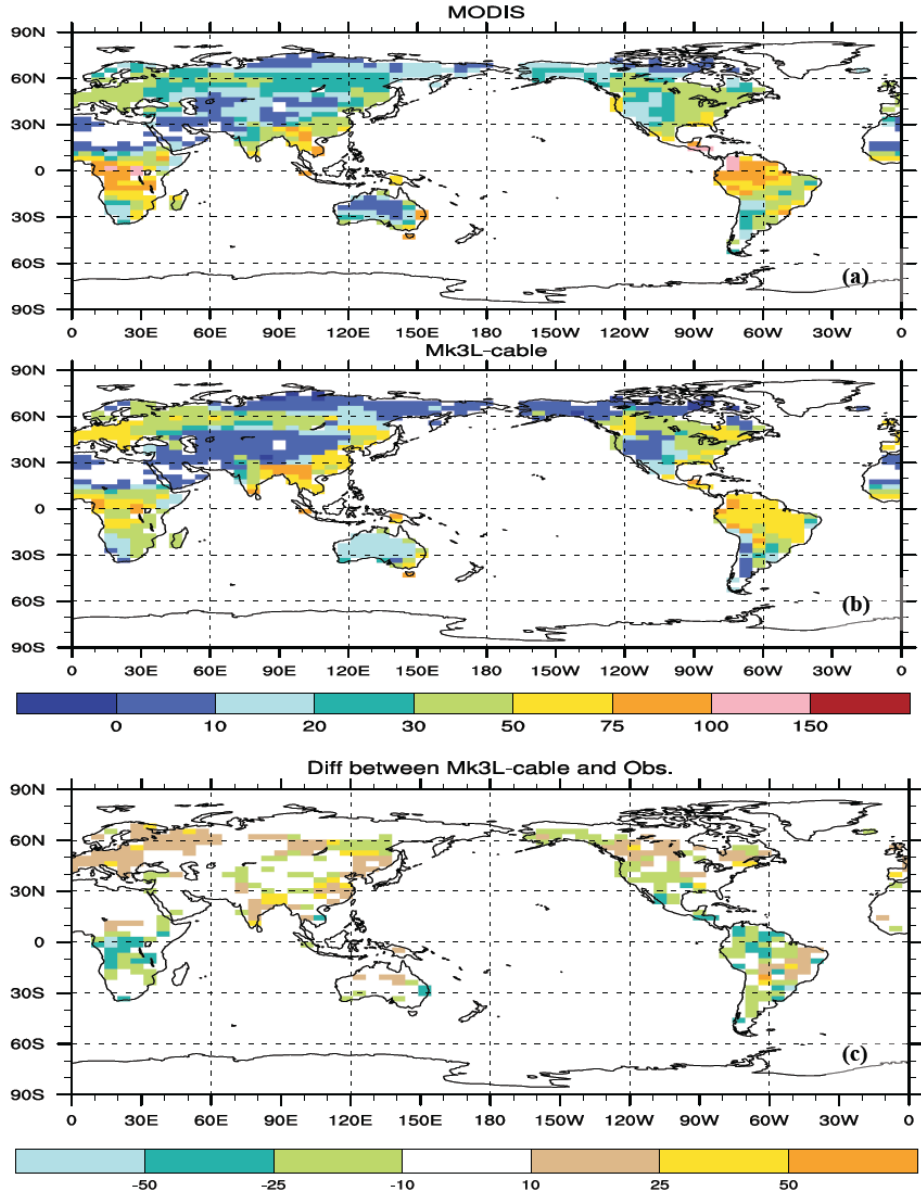
Fig. 8. Annual mean net primary productivity (gCm − 2 month − 1 ) from (a) MODIS MOD 17-vegetation production (Zhao et al., 2005); (b) Mk3L-CABLE and (c) Mk3L-CABLE minus